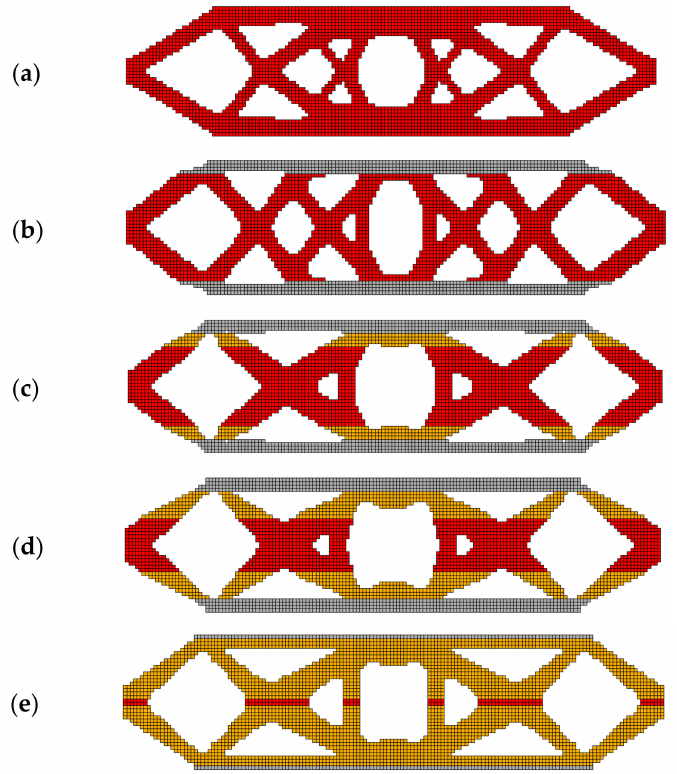
Figure 14. The final topologies generated for the rectangular structure for the 6 distributions of materials: E 1 = 10 11 Pa and E 2 = 10 12 Pa, indicated in Figure 6. SIMP interpolation scheme: ( a ) one material structure, E 1 —red color, minimal compliance: 14.624 × 10 − 4 Nm; ( b ) two materials structure: E 1 —red color, E 2 —gray color, minimal compliance: 5.644 × 10 − 4 Nm; ( c ) two materials structure: E 1 —red color, E 2 —gray color, including 4 layers of FGM interface—yellow color, minimal compliance: 5.112 × 10 − 4 Nm; ( d ) two materials structure: E 1 —red color, E 2 —gray color, including 8 layers of FGM interface—yellow color, minimal compliance: 4.390 × 10 − 4 Nm; ( e ) FGM structure: E 1 —red color, E 2 —gray color, FGM—yellow color, minimal compliance: 3.688 × 10 − 4